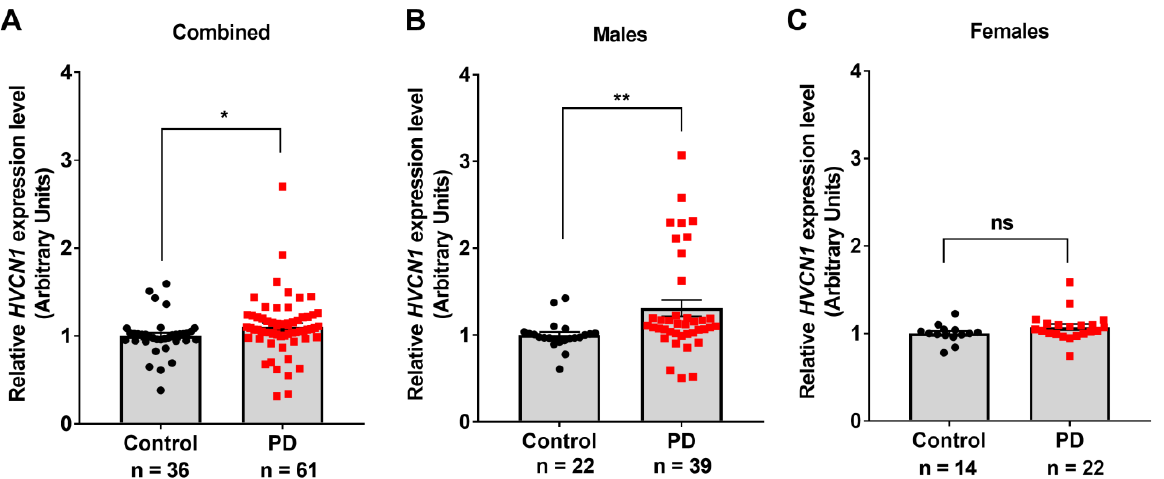
Figure 1. Increased HVCN1 expression in the brain of PD patients. ( A ) HVCN1 expression levels are increased in the substantia nigra of PD patients ( n = 39 males and 22 females) compared to age-matched controls ( n = 22 males and 14 females). ( B ) HVCN1 expression levels in male PD patients compared to male controls from the same studies. ( C ) HVCN1 expression levels in female PD patients compared to female controls from the same studies. GEO numbers were normalized to 1 to generate relative expression values and allow comparison between datasets. Datasets were analyzed by Mann–Whitney non-parametric test. Asterisks denote statistically significant differences—* p < 0.05, ** p < 0.01, and ns = not statistically significant. Error bars denote the standard error of the mean.